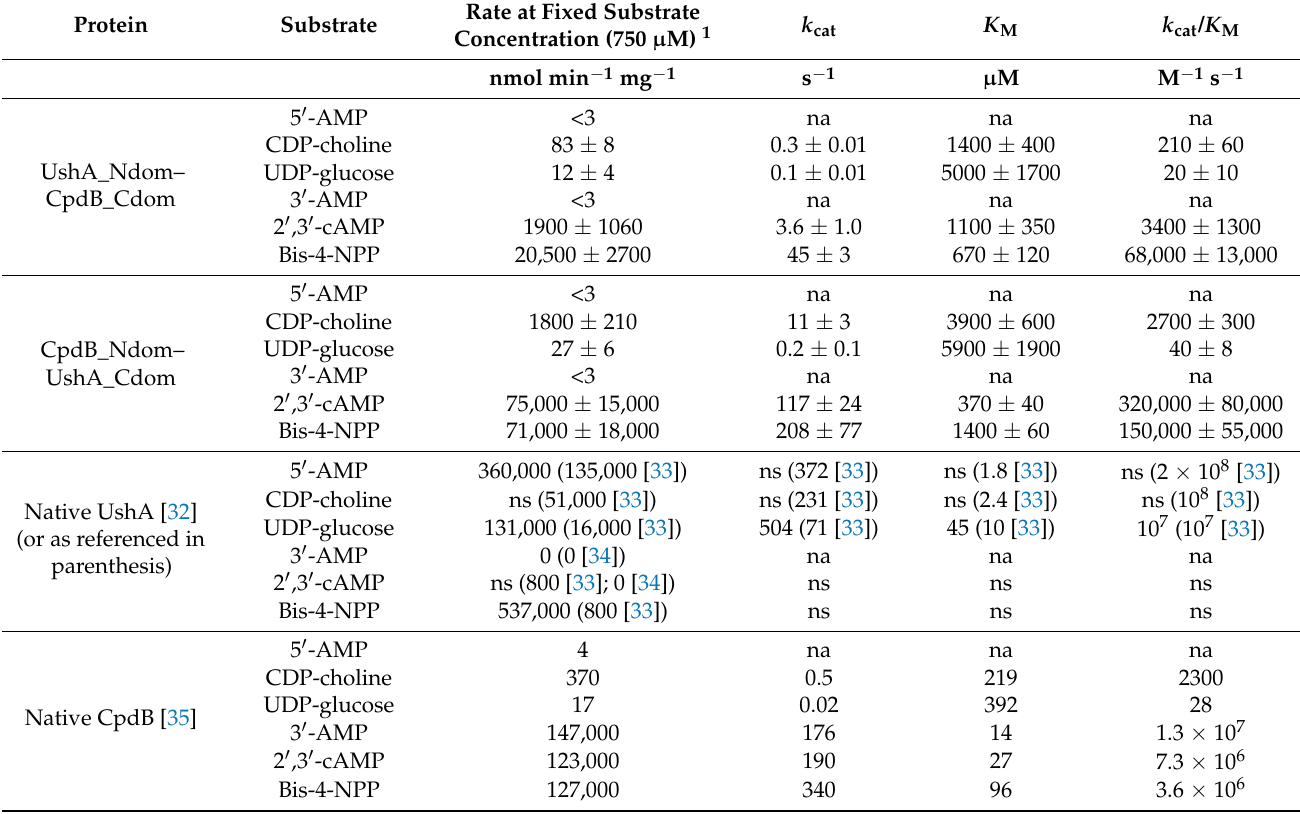
Table 1. Substrate specificity and kinetic parameters of UshA_Ndom–CpdB_Cdom and CpdB_Ndom–UshA_Cdom. All of the data for chimeras were obtained with Mn 2+ as the activating cation. The kinetic parameters were derived from the saturation curves that are shown in Figure 3. The results are expressed as mean values ± standard deviations of 3–8 replicates. Native-enzyme data are from earlier work (UshA [32–34]; CpdB [35]) shown here only for comparison with the chimeras: all of them correspond to Mn 2+ -dependent activities [32,35], except some UshA data that were obtained with Mg 2+ [33] or Co 2+ and Ca 2+